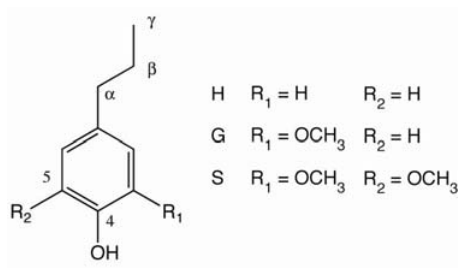
Figure 1. Lignin phenylpropanoid